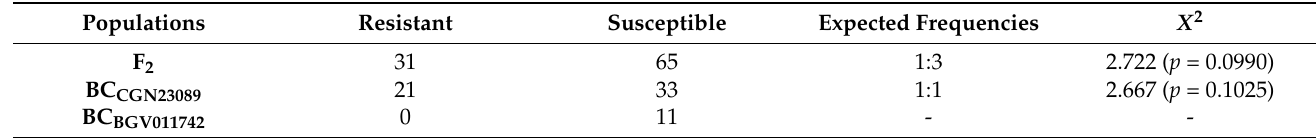
Figure 2. ( A ) Relative ToLC NDV accumulation (2 ( − ∆∆ Ct) ) at 30 days after mechanical inoculation 2 (dpi) with ToLCNDV in the five asymptomatic Indian accessions (CGN22297, CGN22986, CGN23089, CGN23423, and CGN23633) and in four susceptible controls (BGV002494, BGV010301, BGV011742, and BGV014959). ( B ) Relative ToLCNDV accumulation (2 ( − ∆∆ Ct) ) at 15 and 30 dpi (light and dark bars, respectively) of plants obtained by selfing the CGN23089-3, CGN23423-2, and CGN23623-2 genotypes and of the F1 (CGN23089-2 x BGV011742) hybrids. On the x axis, accessions and number of plants of each accession are indicated. Bars sharing the same letter are not significantly different, according to ANOVA and LSD tests ( p ≤ 0.05). Table 3. Number of resistant and susceptible plants in each segregating population according to symptom development and ToLCNDV titers. The probability of X 2 value was calculated for the expected ratio of one recessive gene controlling the 1